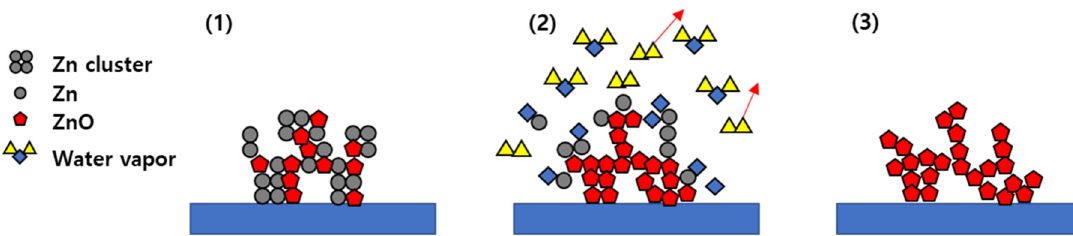
Figure 9. Mechanism of oxidation for the porous Zn-ZnO composite films. ( 1 ) Deposition of Zn-ZnO composite cluster, ( 2 ) Reaction of water vapor with Zn in the cluster, and ( 3 ) Formation of highly porous ZnO film.